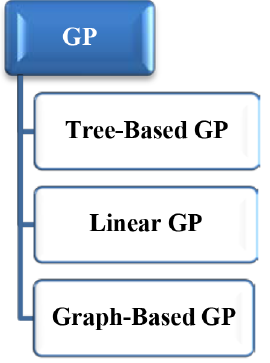
Fig. 1. Different types of genetic programming (Alavi, Gandomi 2011)